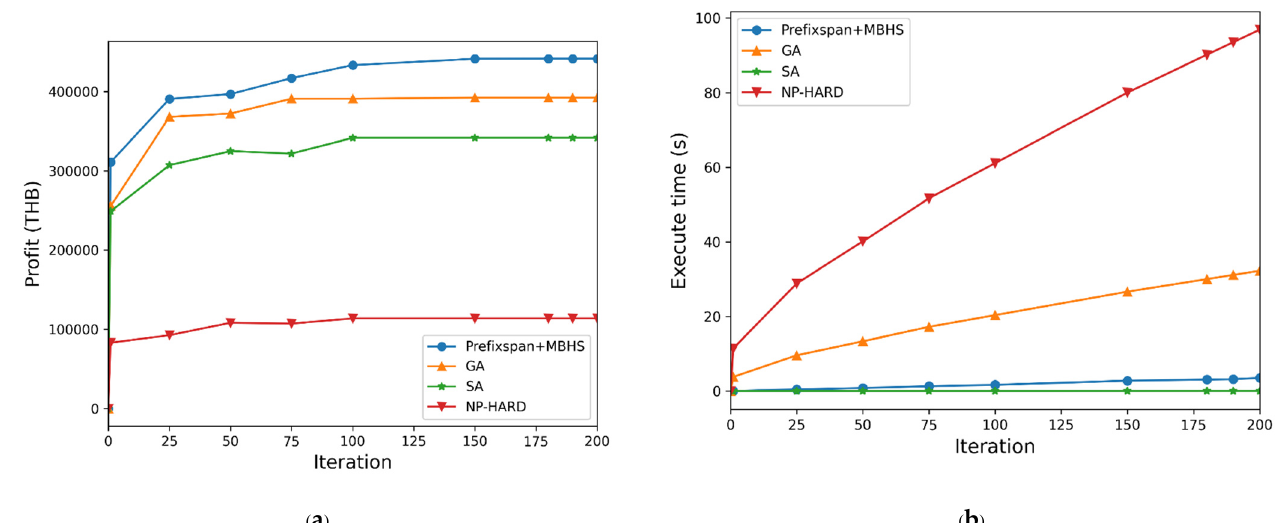
Figure 6. Comparison of the profit volume and execution time as the number of iterations increased: ( a ) profit volume of the algorithms; ( b ) execution time of the